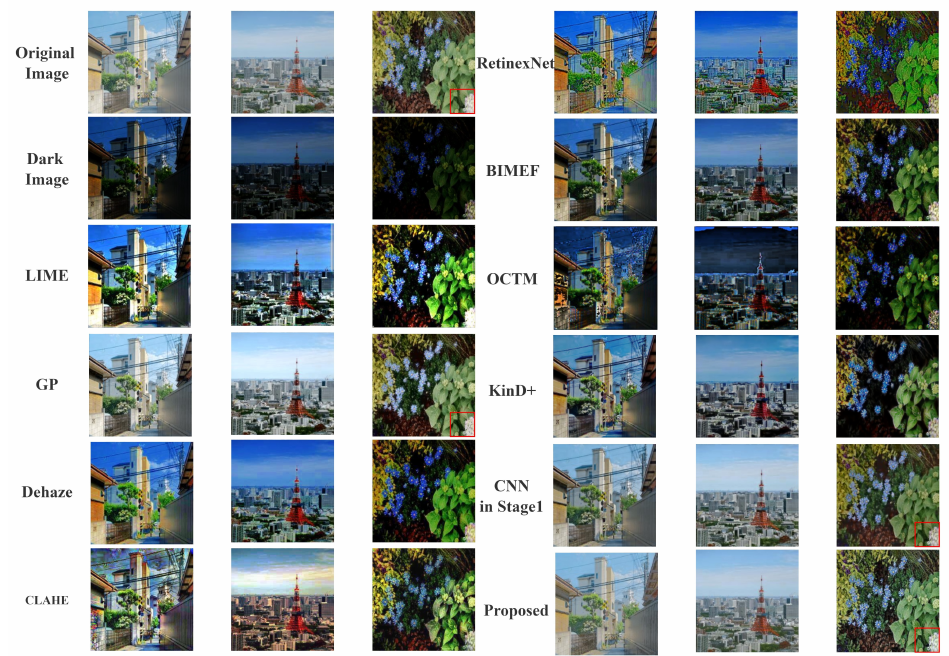
Figure 7. More examples of low-light enhancement on synthesized low-light images. The part represented by the red box has been enlarged and is shown in Figure 8.